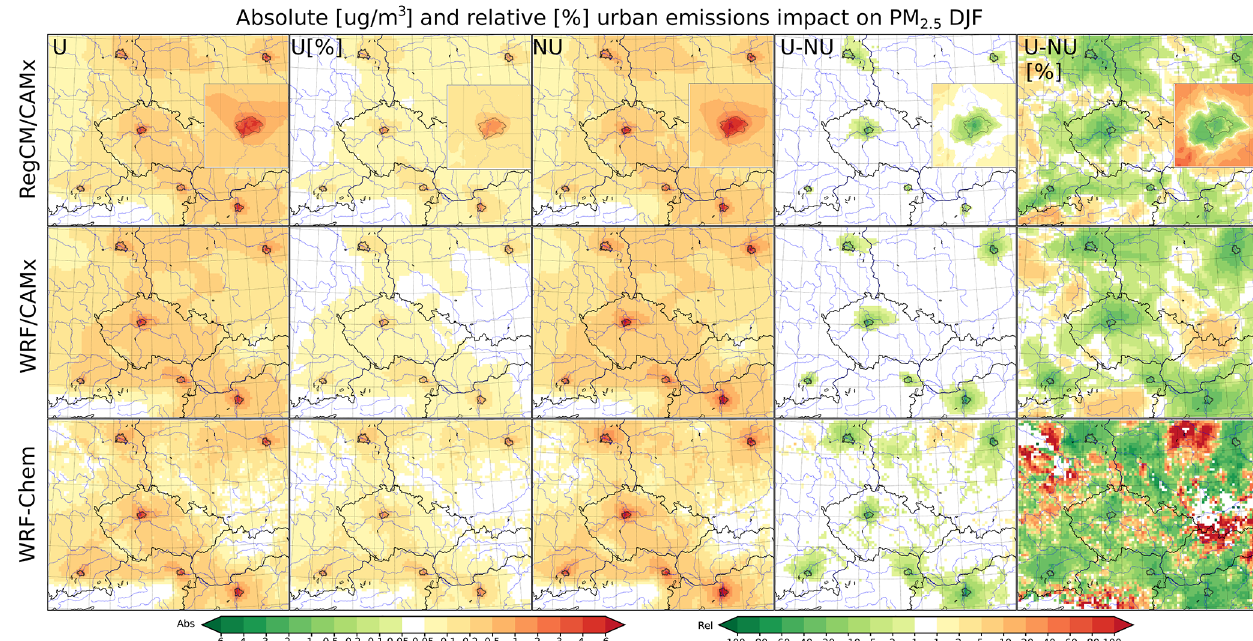
Figure 6. Same as Fig. 4 but for PM 2 . 5 (in µgm − 3 ).